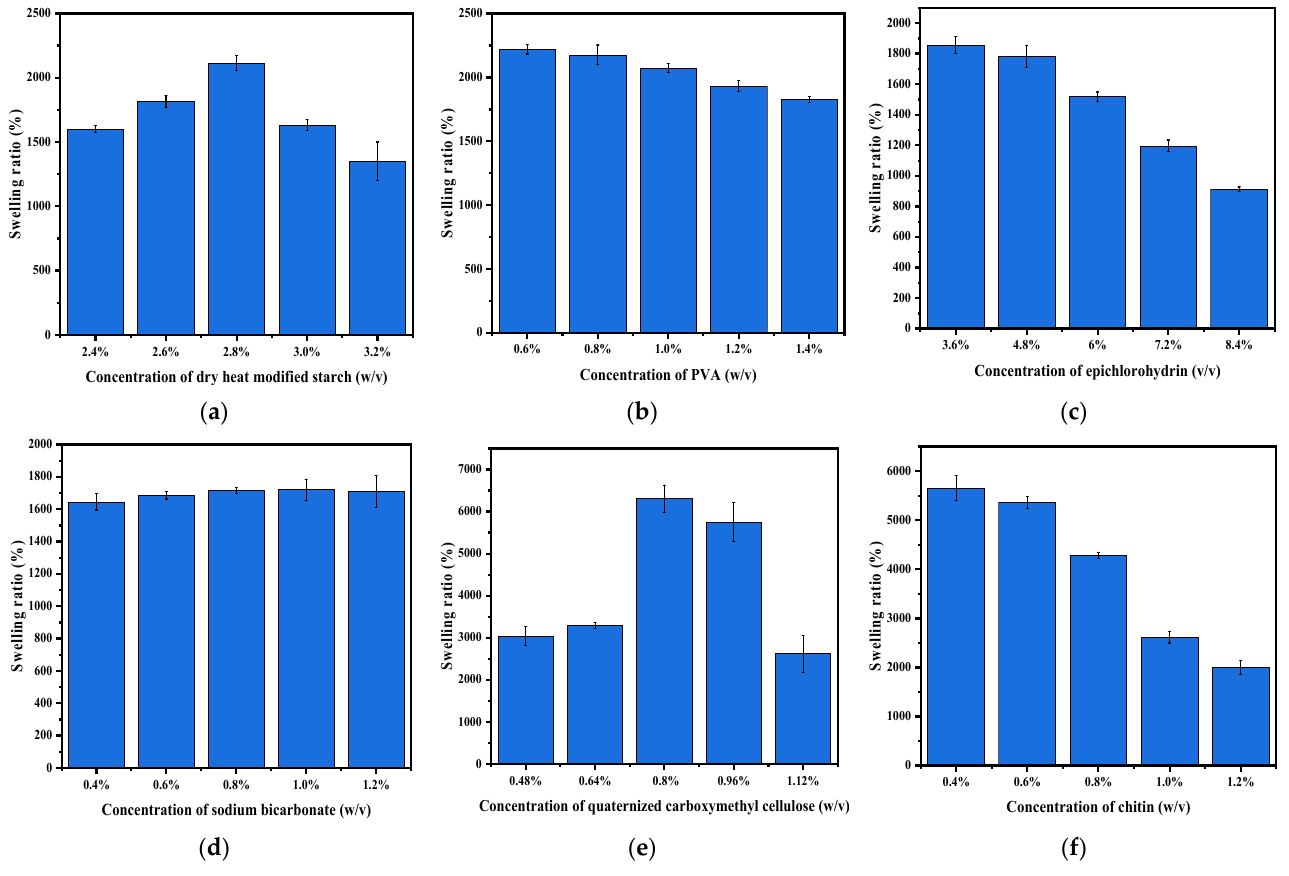
Figure 2. Swelling ratios of hydrogels with different component concentrations in distilled water: ( a ) dry heat-modified starch, ( b ) polyvinyl alcohol, ( c ) epichlorohydrin, ( d ) sodium bicarbonate, ( e ) quaternized carboxymethyl cellulose, and ( f ) chitin.